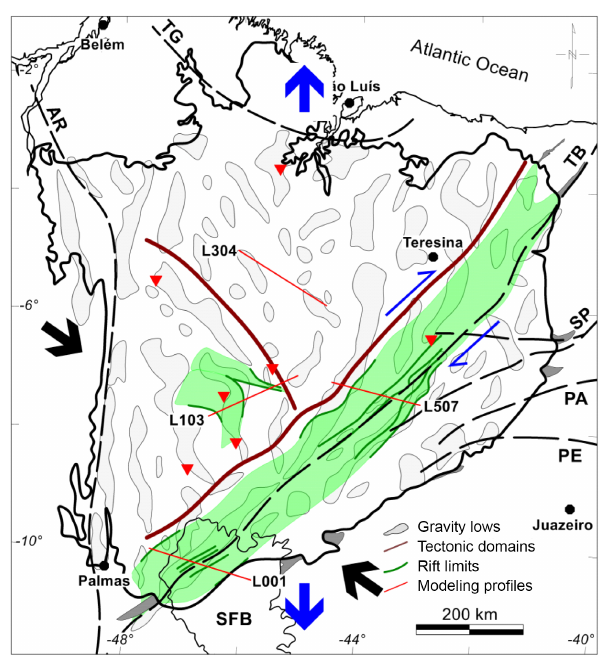
Figure 14. Simplified tectonic domains of the Parnaíba basin, show- ing outcropping marginal troughs (dark gray areas), seismic derived Cambrian–Ordovician rift zones (green areas) and gravity lows (light gray areas). Arrows indicate Brasiliano collisional (black) and post-orogenic extensional (blue) stresses. Red triangles indicate low-grade metasedimentary rocks drilled in exploratory wells.